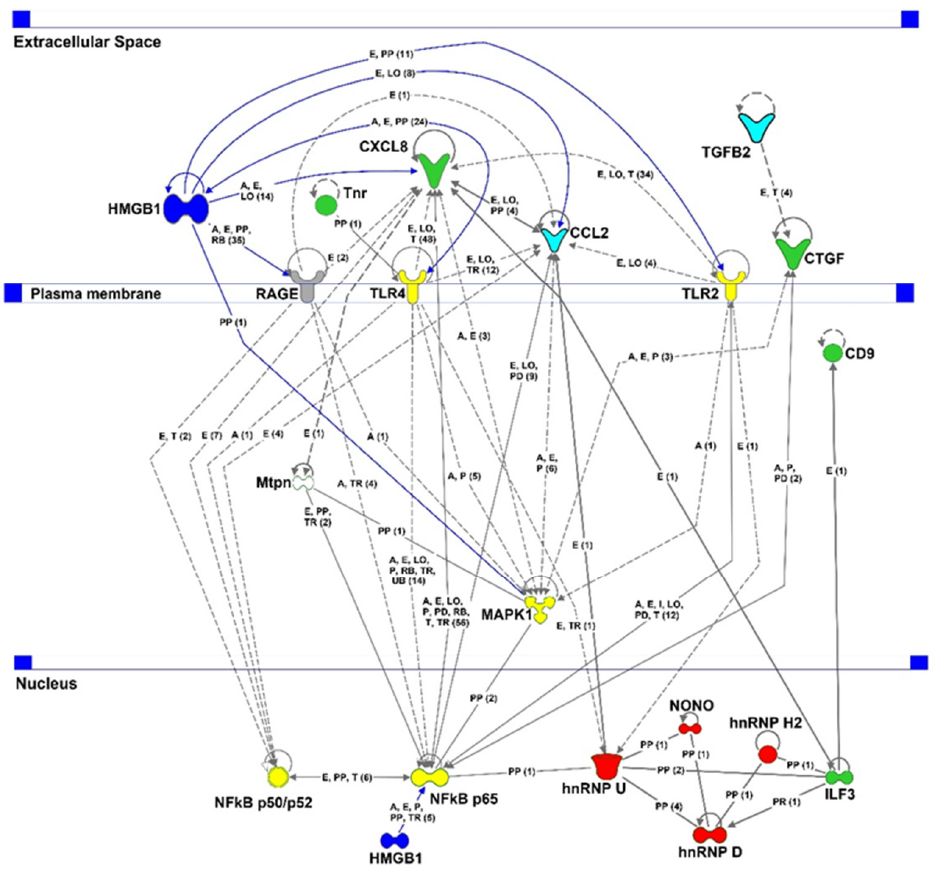
Figure 8. IPA interaction network of selected proteins identified by mass spectrometry or microarray. The significantly downregulated proteins in the Ab-treated group compared with the control group are shown in green; the upregulated proteins are shown in red. Selected proteins identified by microarray or mass spectrometry that were not significantly different in the groups studied are yellow. The proteins shown in grey show considerable interactions with the differentially expressed proteins shown by previous studies. Legend: A = activation; L = proteolysis; P = phosphorylation/dephosphorylation; PP = protein–protein binding; I = inhibition; E = expression; PD = protein–DNA binding; TR = translocation; MB = group/complex membership; solid arrow = direct interaction; dashed arrow = indirect interaction; (count) = number of scientific references on the respective relation; if not indicated differently in the figure, the arrowhead indicates “acts on”.